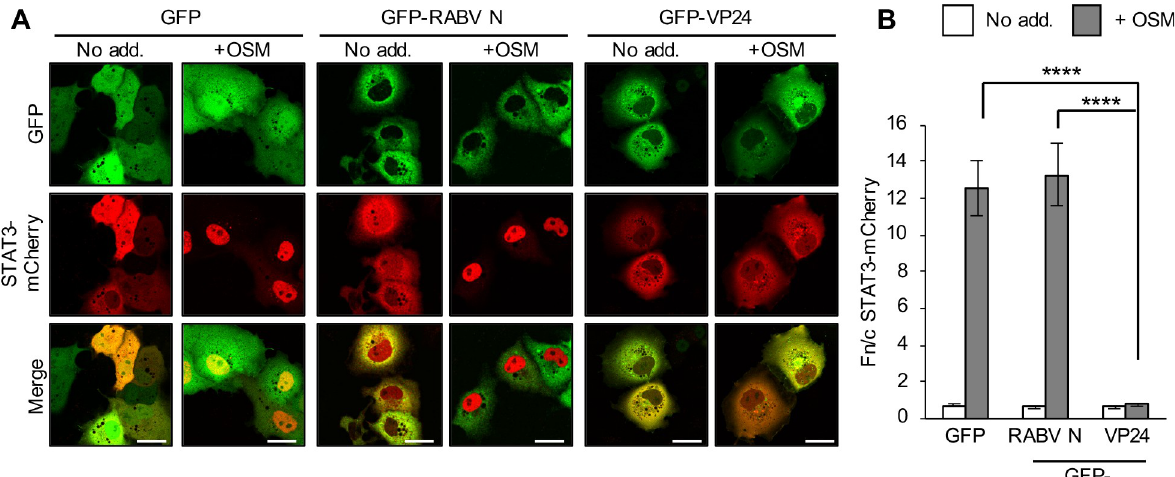
Fig 3. EBOV VP24 protein expression inhibits STAT3 responses to OSM. COS7 cells co-transfected to express the indicated proteins were treated 24 h post-transfection with or without OSM (10 ng/ml, 30 min) before live-cell CLSM analysis (A) to determine the Fn/c for STAT3-mCherry (B; mean ± SEM; n � 35 cells for each condition; results are from a single assay representative of two independent assays). Scale bars, 30 μ m. RABV N, rabies virus N-protein. Statistical analysis used Student’s t -test; ���� , p < 0.0001.